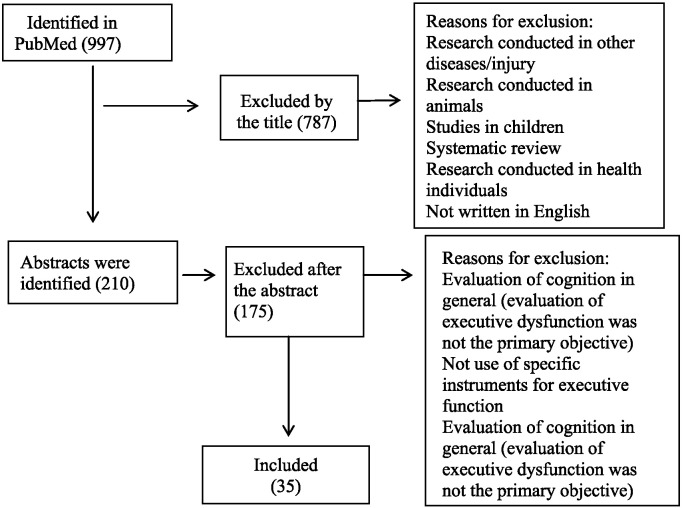
Flow diagram: identified manuscripts and reasons for exclusion.